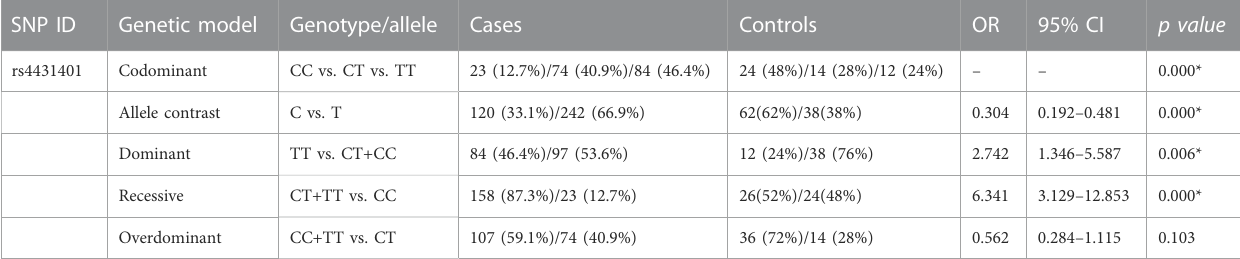
TABLE 2 Genotypic and allelic distribution of the CD73 gene between all patients and controls. SNP ID